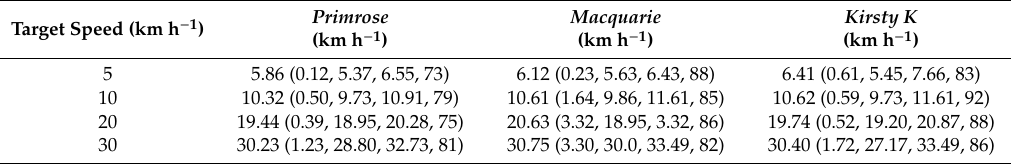
Table 2. Transect speeds conducted by each vessel (standard deviation, minimum and maximum speeds and the number of analyzed recordings shown in parentheses).